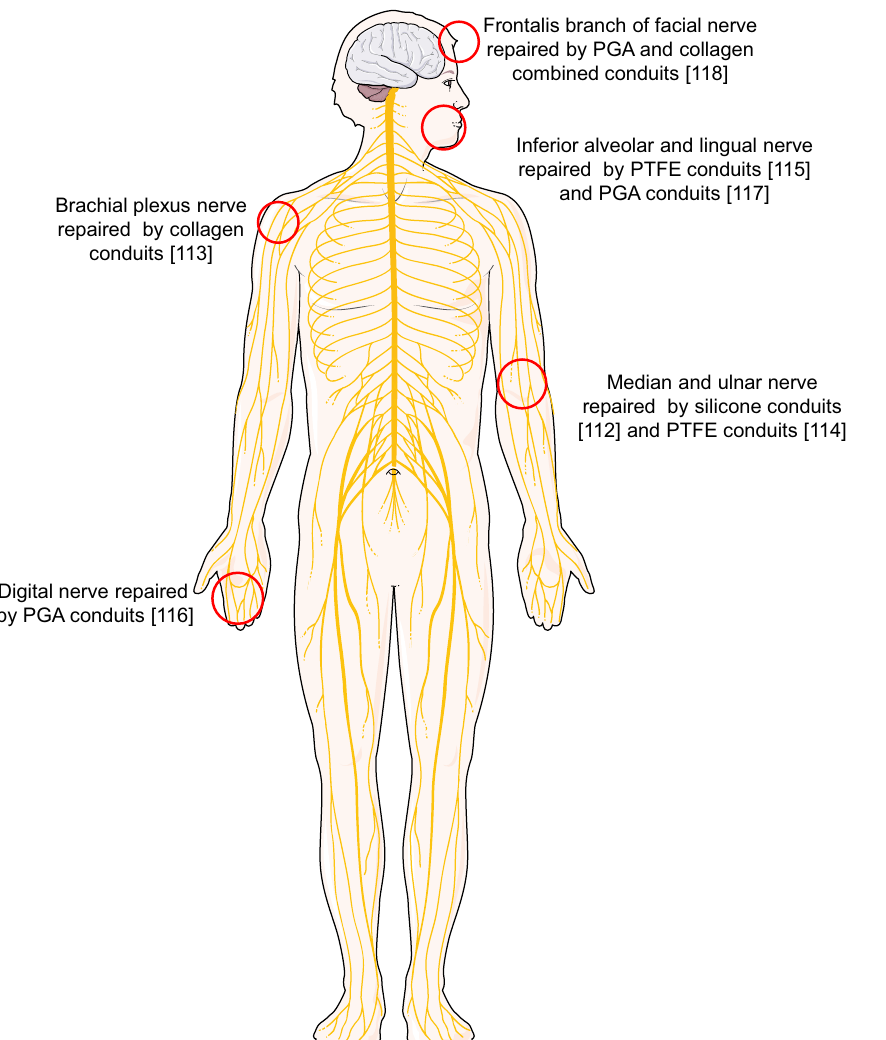
Figure 3: Schematic illustration of clinical trials of peripheral nerve repair with di ff erent types of nerve conduits at di ff erent anatomic